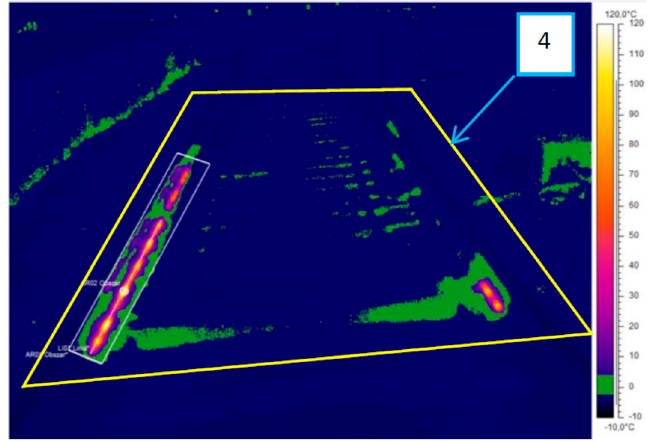
Figure 14. Thermogram IR_0145, iron colour palette, the isotherm tool is defined, and the area of effective influence of EOR devices is adopted (source: authors).